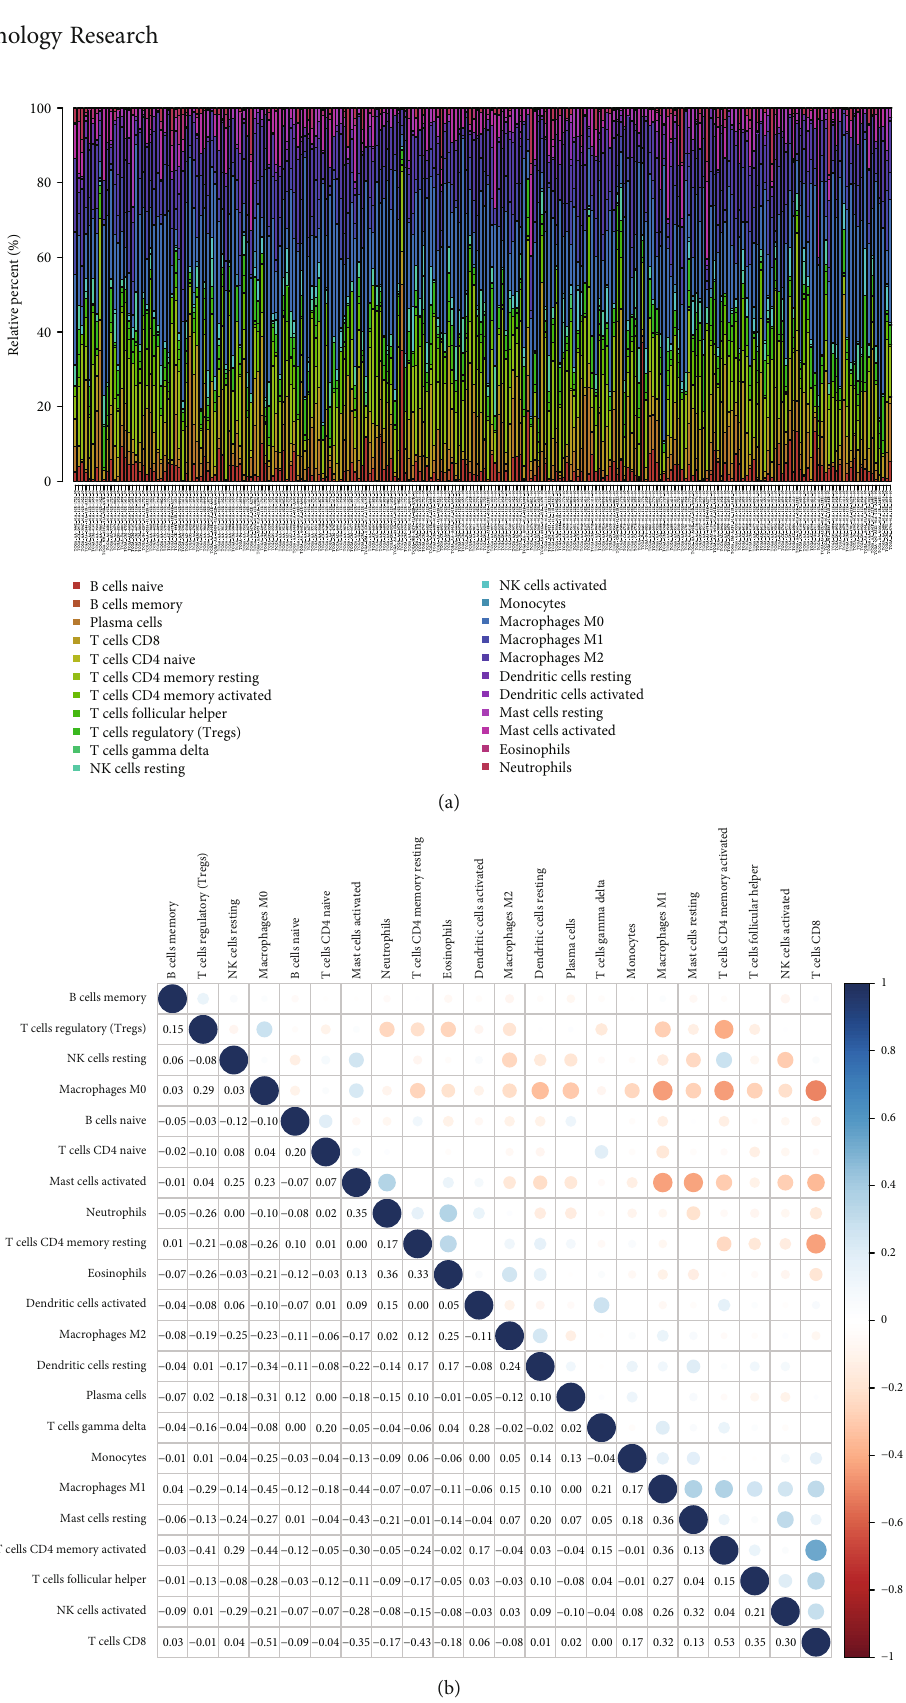
Figure 7: TIC pro fi le within tumor samples and relationship investigation. (a) The landscape of immune in fi ltration in CRC tissues. (b) Relationship matrix of all 22 TIIC